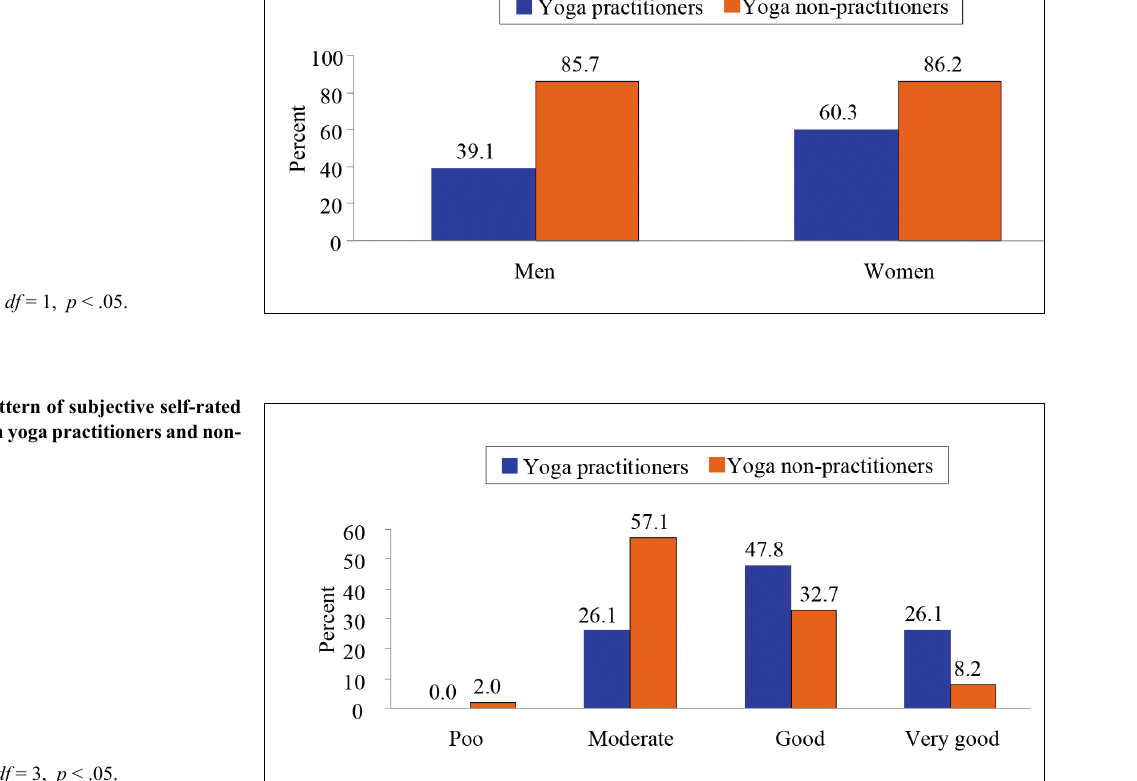
Figure 10. Pattern of alcohol consumption in yoga practitioners and non-practitio - ners